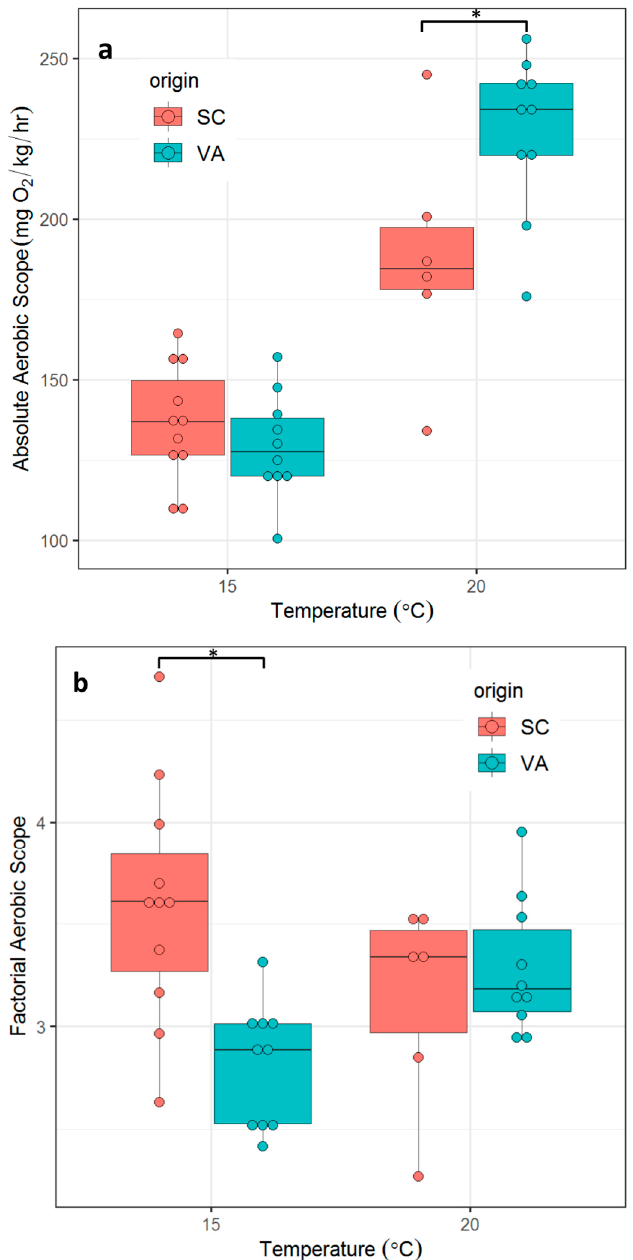
Figure 5. Absolute aerobic scope (AAS, a ) and factorial aerobic scope (FAS, b ) between two northern and southern spotted seatrout populations, at 15 °C and 20 °C. SC = southern population, VA = northern population. Asterisks indicate significant differences between groups ( p ≤ 0.05, two tailed Student’s t-test).